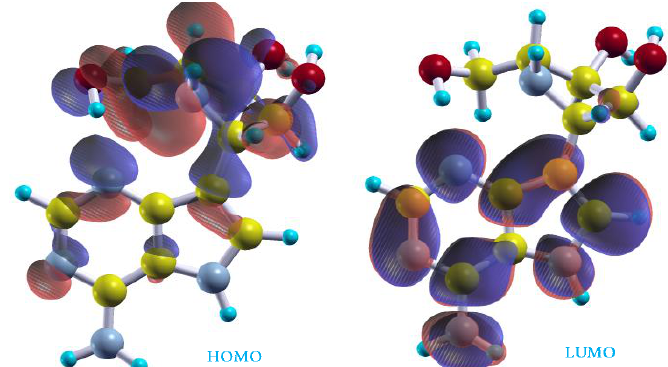
Fig. 6. The isosurfaces of HOMO (left) and LUMO (right) molecular orbitals of bare IMMUCILLIN-A molecule, where |0.02| was used as an isovalue of the molecular